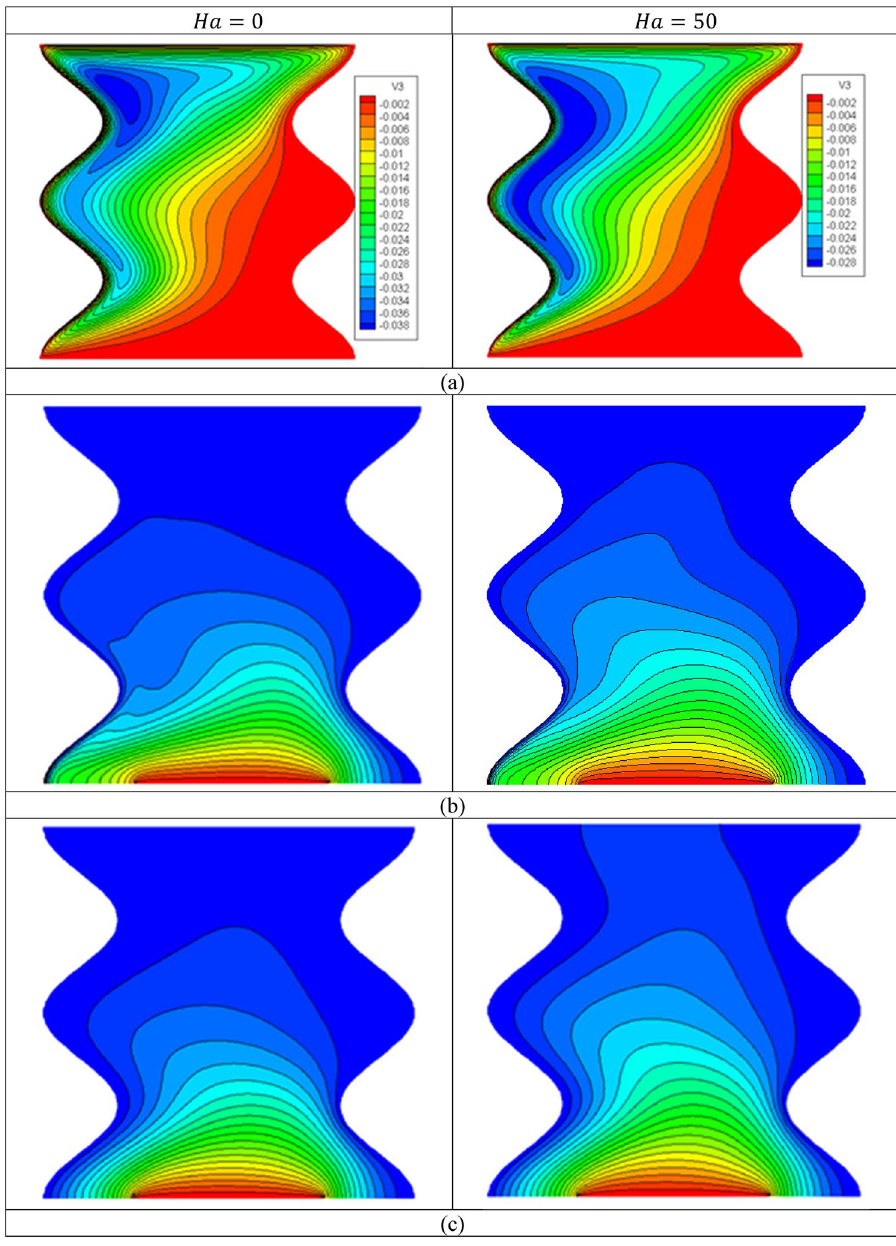
Figure 11. Contours of ( a ) streamlines, ( b ) isotherms of a fluid phase, and ( c ) isotherms of a solid phase below the changes on the Hartmann number Ha for hybrid nanofluid at φ Cu = φ TiO 2 = φ/ 2, φ = 0.05, B = 0.5, Q = 1, R d = 0.5, Da = 10 k fs = 1, D = 0.5, k r = 1, H ∗ = 10